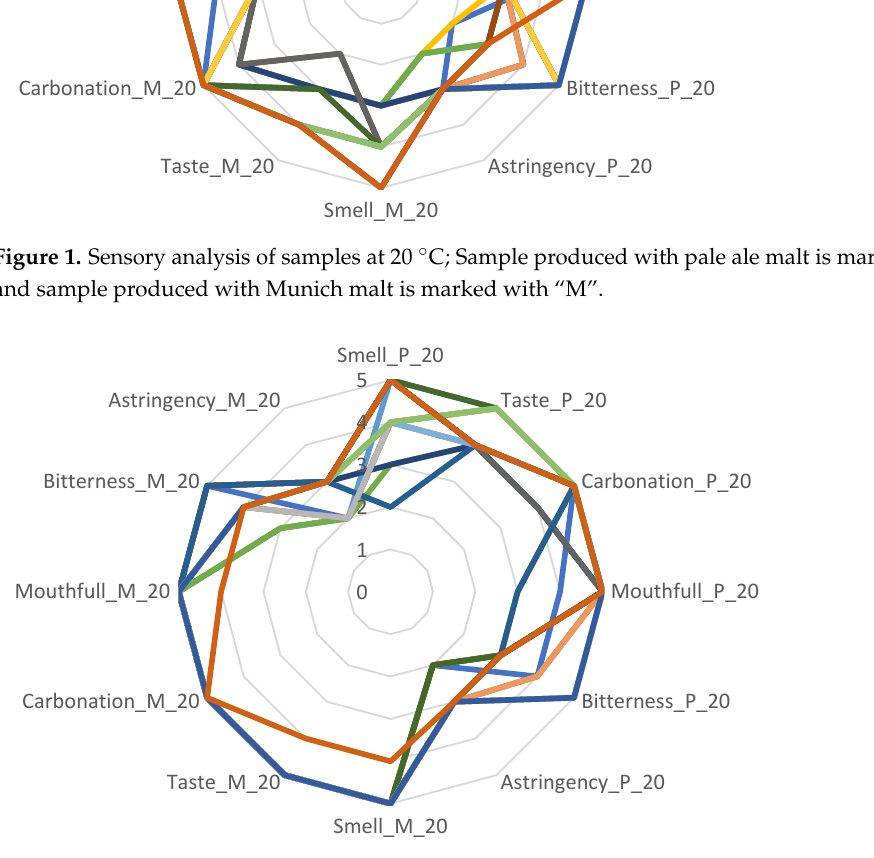
Figure 2. Sensory analysis of samples at 4 °C; Sample produced with pale ale malt is marked as “P” and sample produced with Munich malt is marked with “M”.